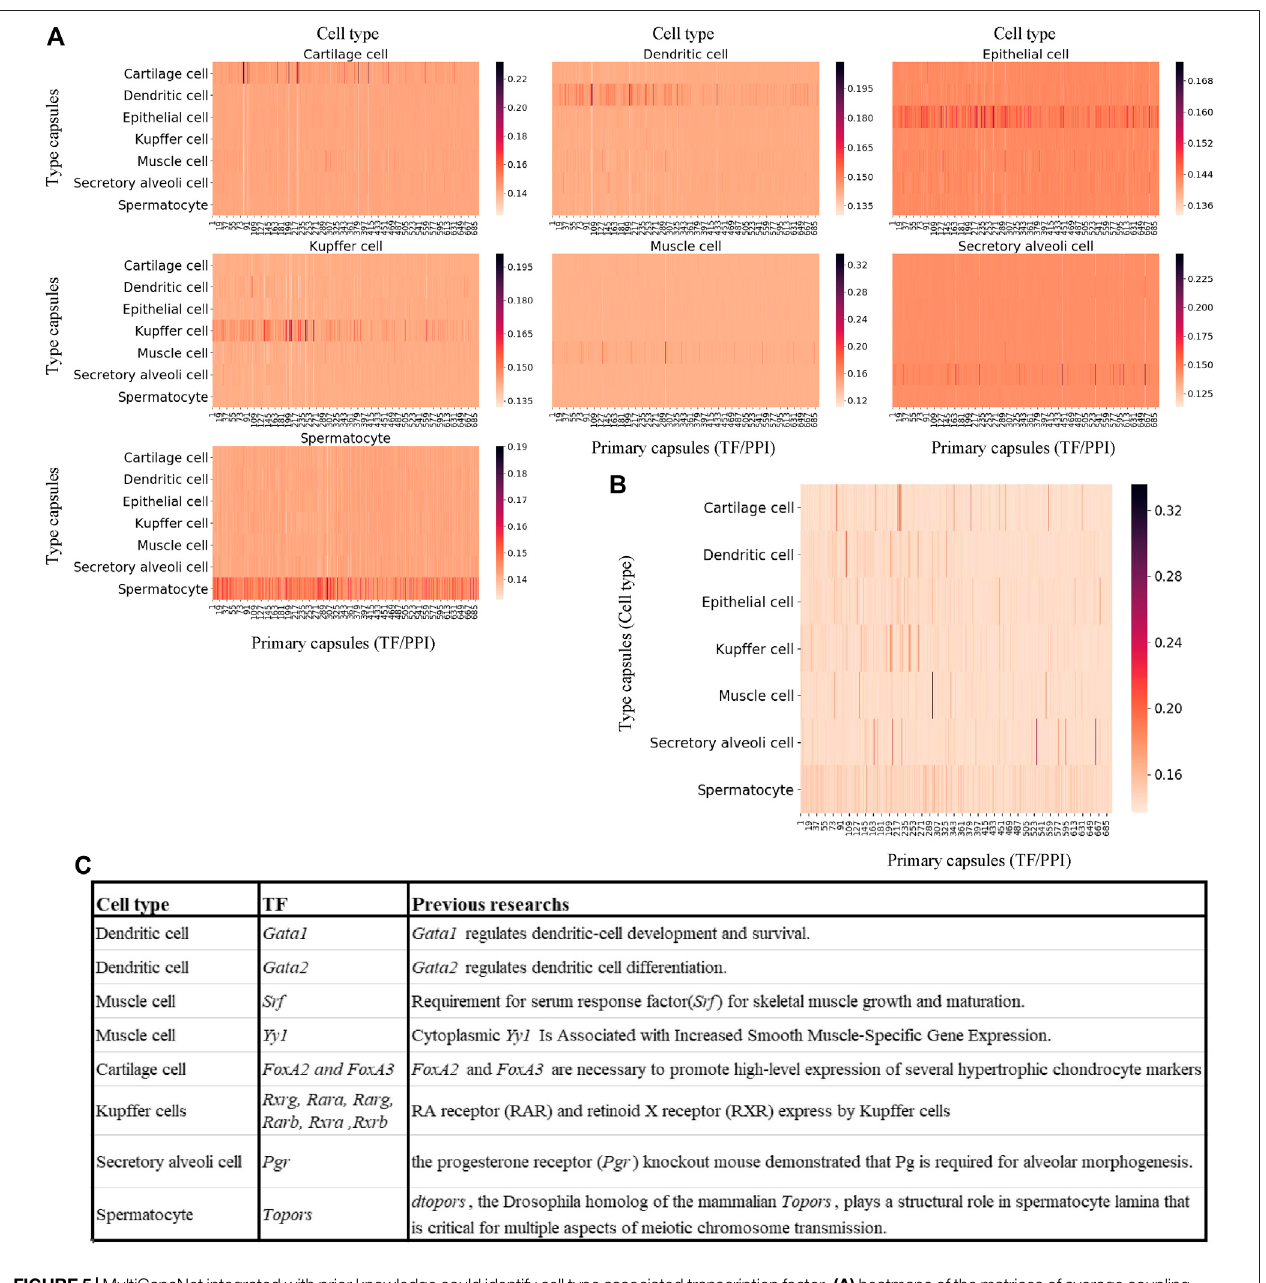
FIGURE5| MultiCapsNetintegratedwithpriorknowledgecouldidentifycelltypeassociatedtranscription factor. (A) heatmapsofthematricesofaveragecoupling coef fi cients for each cell type. In each heatmap, there are 696 columns for 696 primary capsules (TF/PPI) and seven row for seven type capsules (cell types), and each element in the average coupling coef fi cients is represented by a thin line. The brightness of these thin lines (elements in the average coupling coef fi cients) indicate the contribution of the primary capsules (TF/PPI) to the speci fi c cell type recognition. The dark lines (high score elements in average coupling coef fi cients) exclusively reside in the corresponding effective type capsule row in each heatmap. (B) Overall heatmap of the combined matrix of average coupling coef fi cients. The combined matrix contains the effective type capsule rows in Figure 5A where its recognition type is in accordance with the type of single cells input. (C) The table list several top ranked contributors for speci fi c cell type recognition, given by the MuiltCapsNet model, are associated with corresponding cell types which have been reported before.